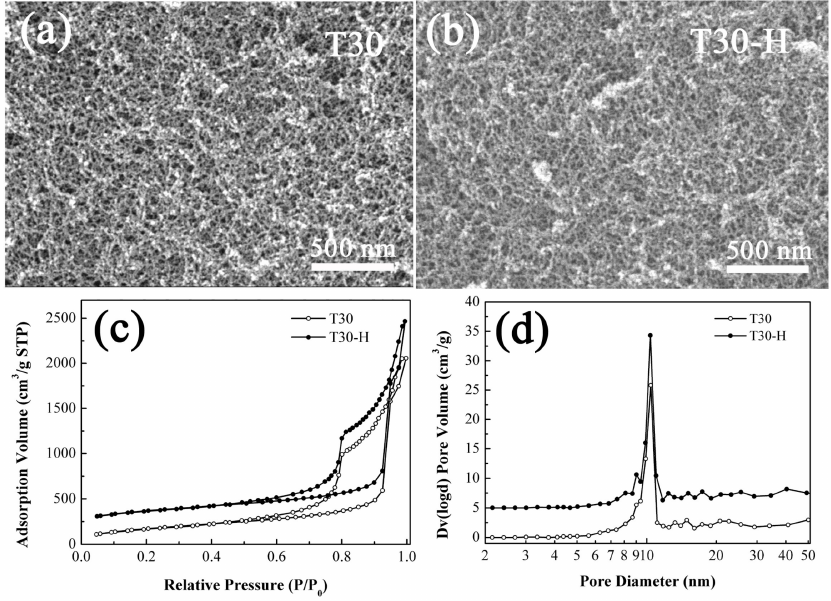
Figure 7. The SEM images of the aerogels T30 and T30-H ( a , b ); N 2 adsorption-desorption isotherms ( c ) and the pore size distributions ( d ) of the aerogels T30 and T30-H.